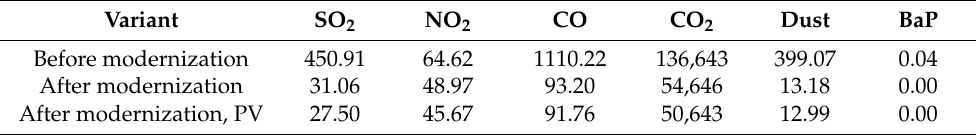
Table 8. Annual emission of pollutants,